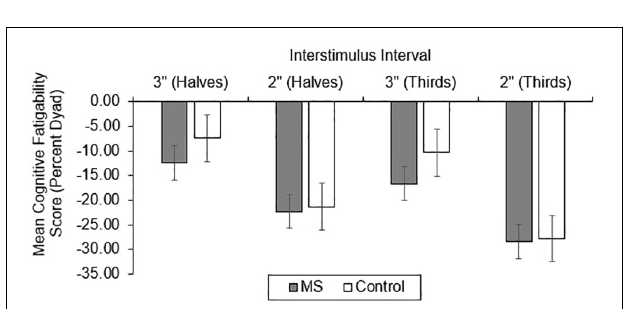
FIGURE 2 | Group difference in dyad performance scores.